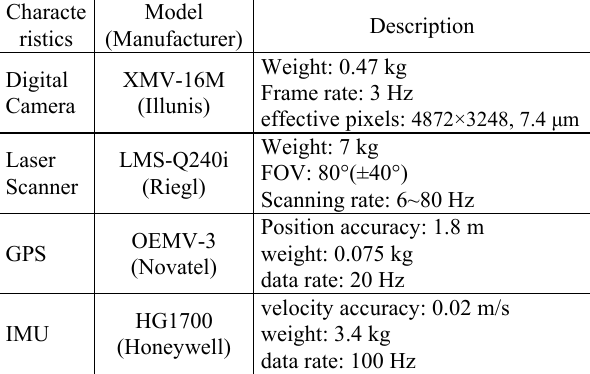
Table 1. Sensor specification on board RAMS